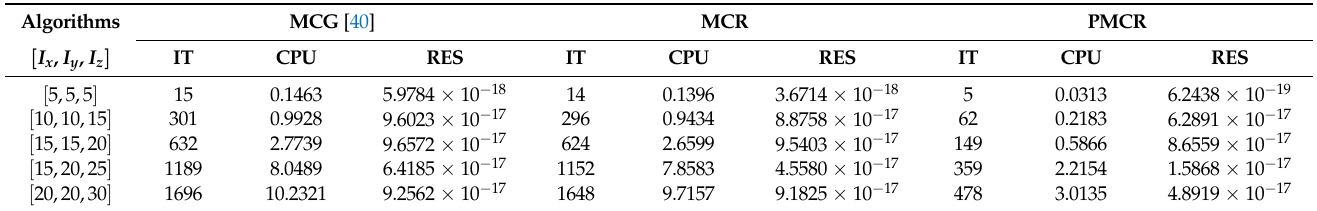
Table 1. Comparison results of Example